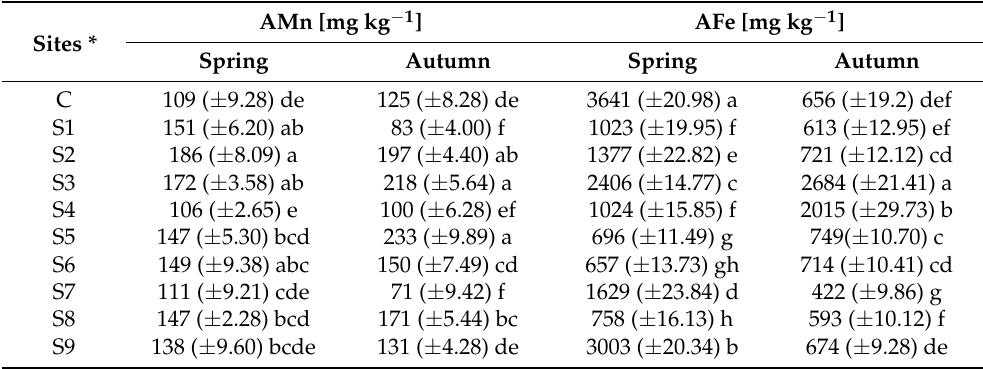
Table 4. Content of available forms of manganese and iron.